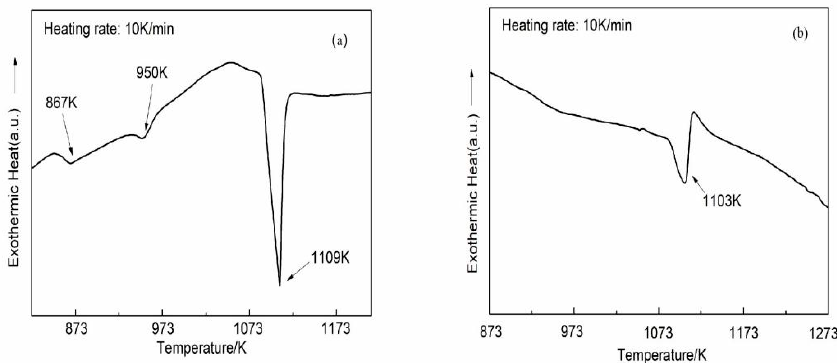
Figure 4. The DSC heating trace: ( a ) The Ti 40 Zr 40 Ni 20 rod; ( b ) The Ti 40 Zr 40 Ni 20 ribbons.